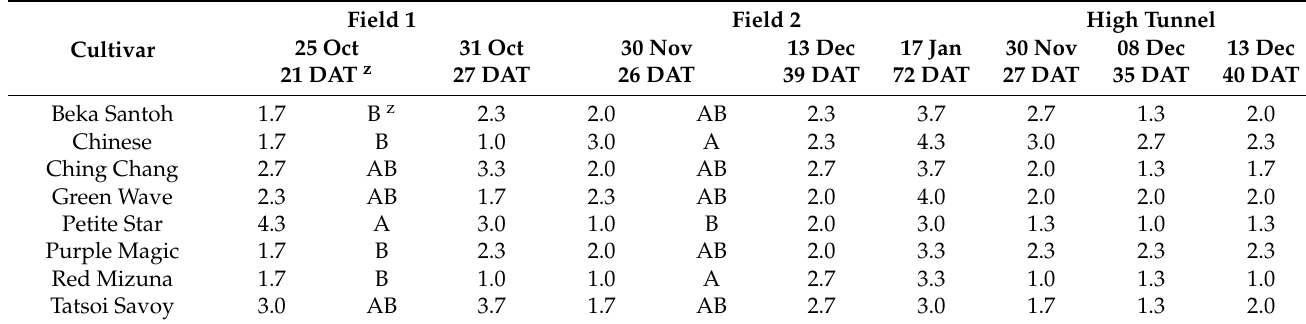
However, no differences were found in leaf Brix for plants grown in the high tunnel, which were harvested on 14 December. Table 4. Visual quality rating of nine cool-season leaf vegetables grown in the open field with two planting dates and in a high tunnel in east Texas. Rating scale from 1 to 10: 1—excellent, 10—dead. For Field 1, seeds sowing, transplanting, and harvest dates: 17 September, 4 October, and 16 November 2018. For Field 2, seeds sown, transplanting, and harvest dates: 8 October, 6 November 2018, 8 February 2019.